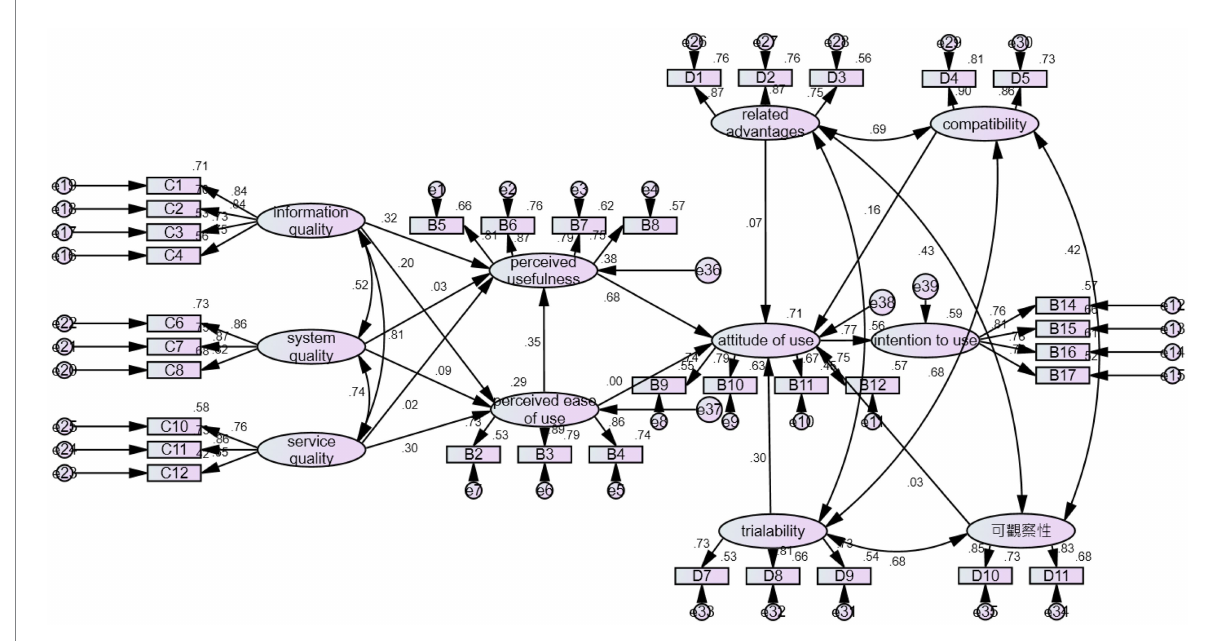
FIGURE 2 Empirical research model of behavioral intentions influencing adoption of distance teaching in Post-epidemic Era.